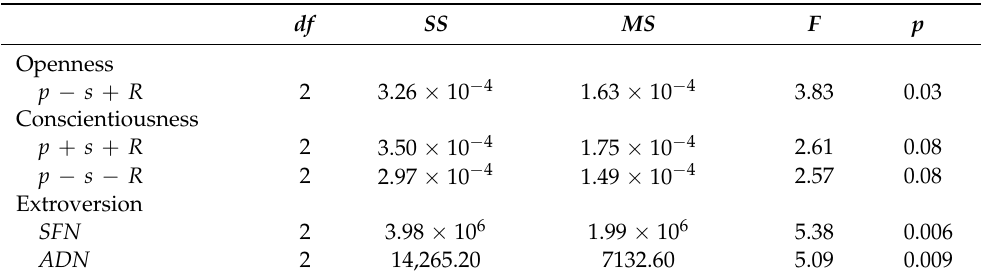
Table 2. Selected MANOVA results for variance in Affective SpaceShooter 2 statistics by NEO-FFI